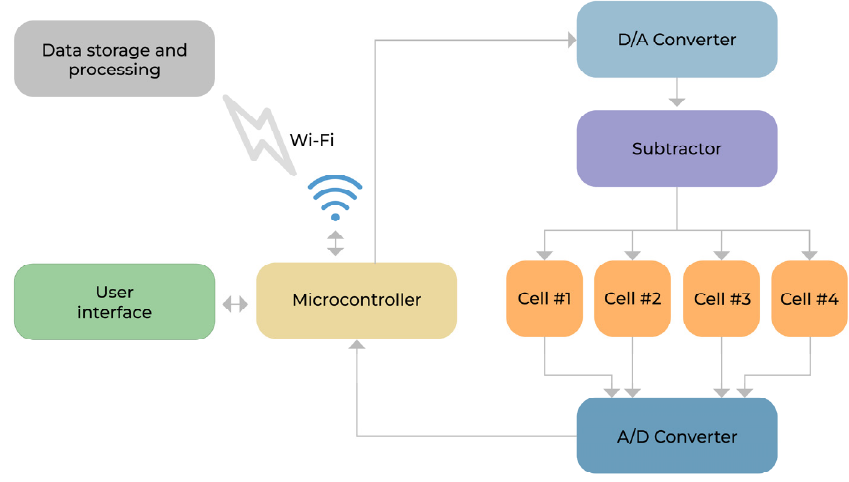
Figure 1. General properties of the voltammetry-based device for detecting antigens and antibodies as a novel tool for syphilis screening. Table 1. Serological status of biological samples and AUC data obtained after incubation with anti-